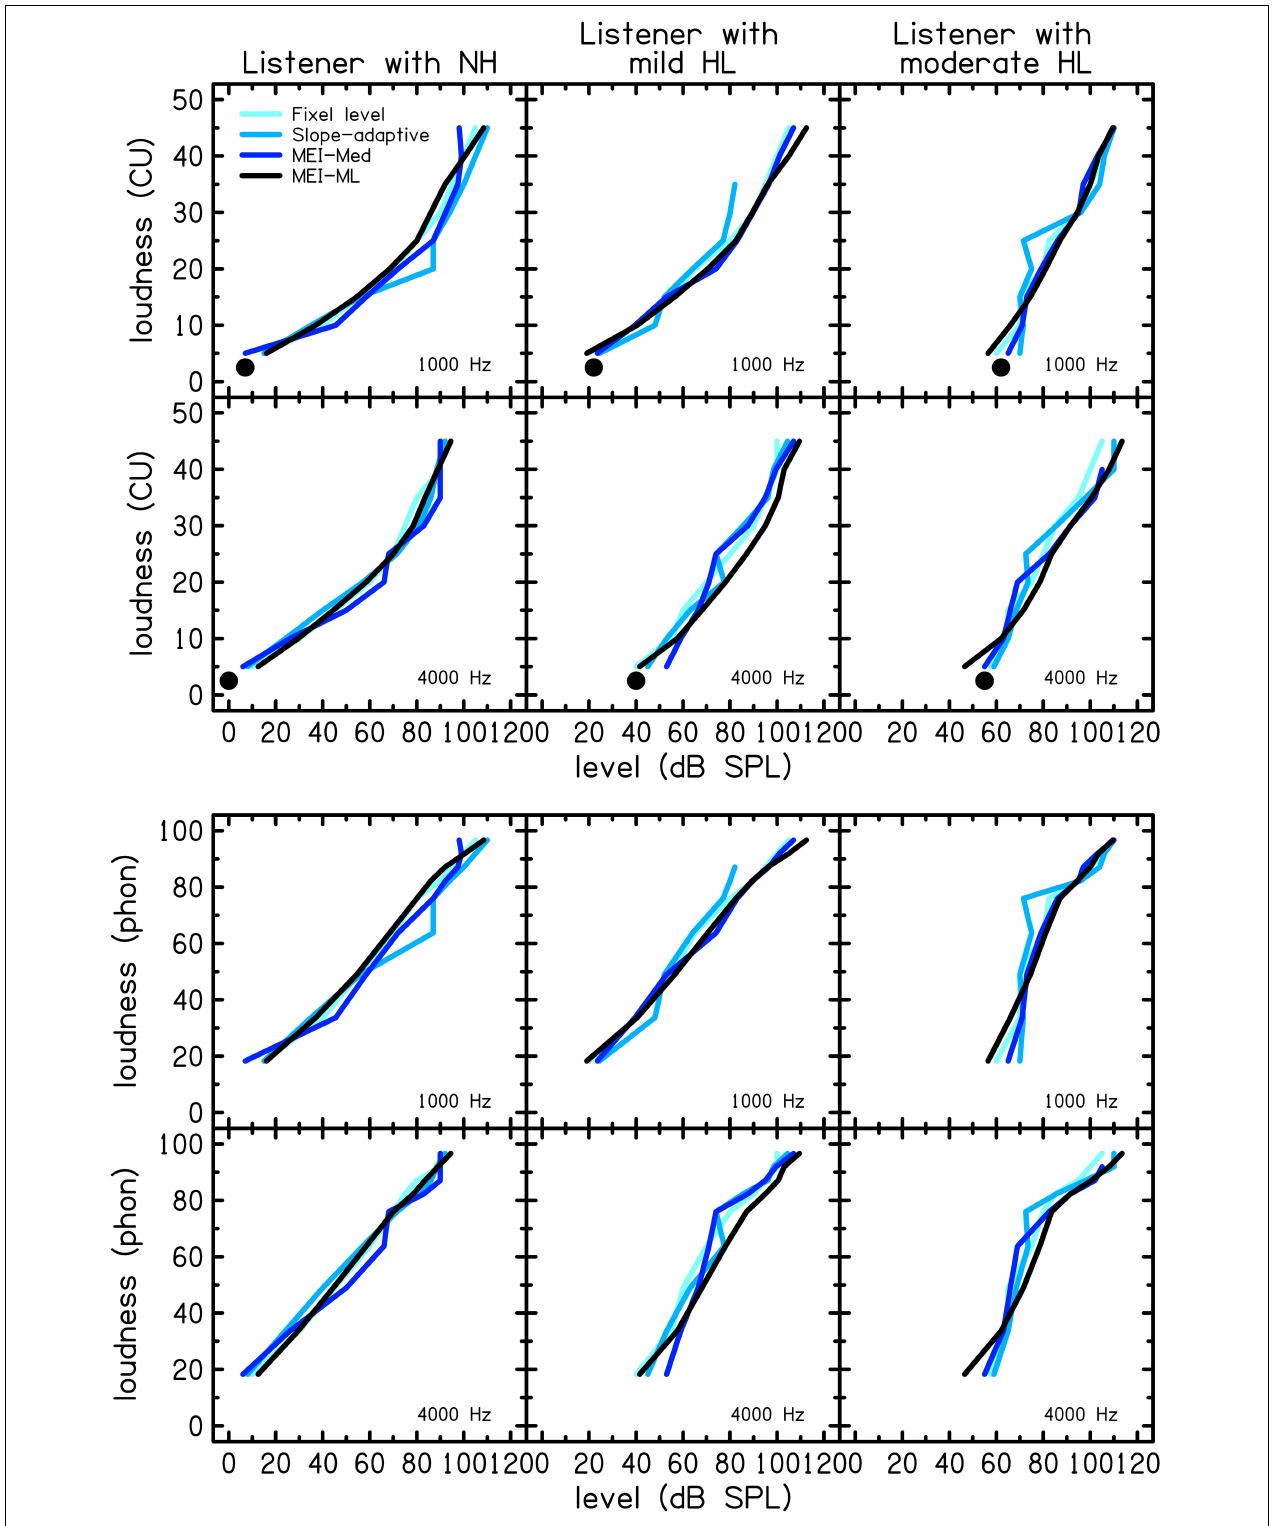
FIGURE 3 | CLS functions for each of the procedures at 1 (top row) and 4 kHz (bottom row) for three individual (representative) participants with normal hearing (NH; left column), mild hearing loss (HL, middle column), and moderate HL (right column). The top set of six panels show loudness in categorical units and the bottom set of six panels show loudness level in phons. The participants’ audiometric thresholds are indicated by a black filled circle.